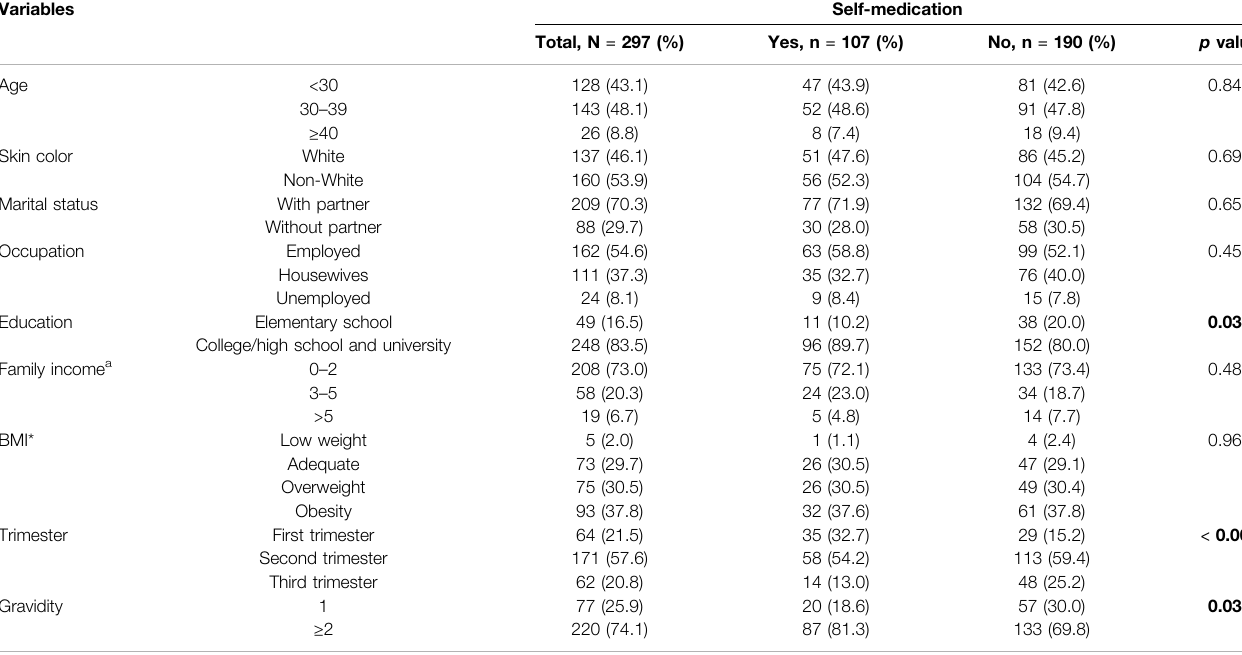
TABLE 1 | Sociodemographic, gestational characteristics and self-medication during pregnancy of 297 women. Variables